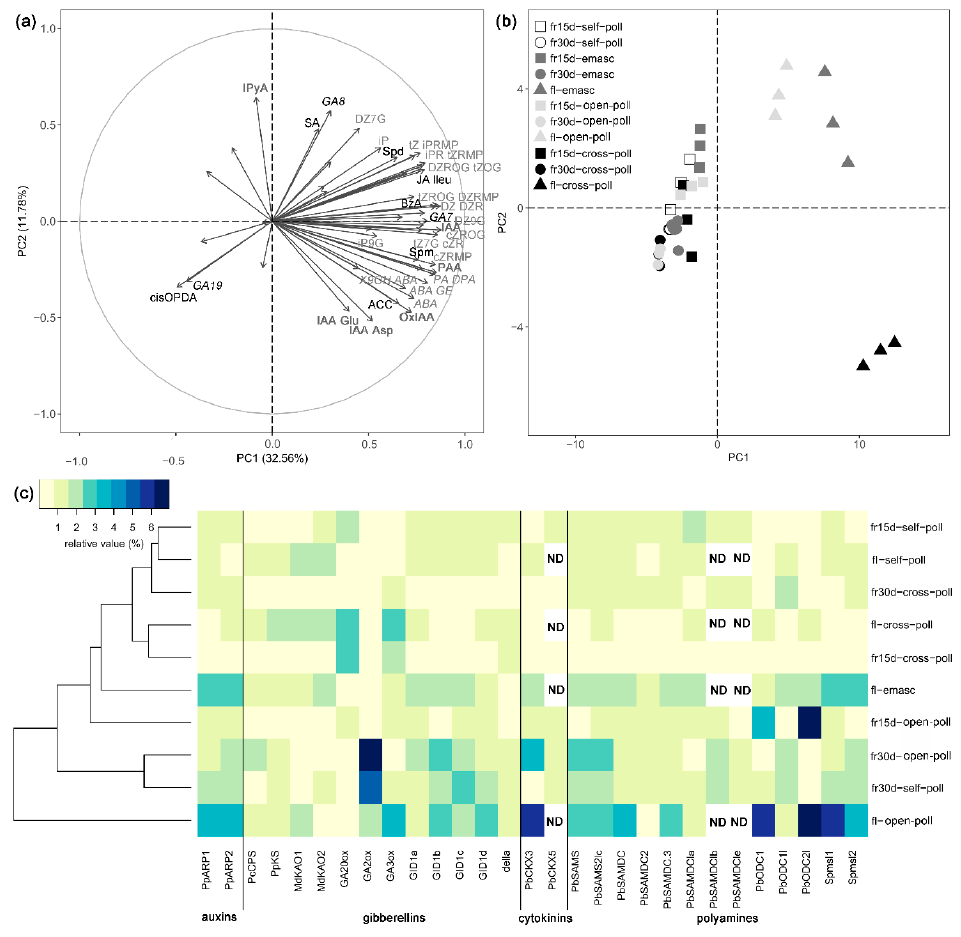
Figure 3. Effects of fertilization and intrinsic parthenocarpy on hormonal regulation during early fruit development of ‘Conference’ pear fruits. ( a - b ) Principal Component Analysis (PCA) of phytohormone and polyamine profiles in flowers and young ‘Conference’ fruits after different pollination and emasculation treatments; (a) variable graph and (b) individual graph; only significant parameters were shown (P< 0.05) in (a). ( c ) Heatmap of relative transcript levels of genes involved in phytohormone and polyamine metabolism and signaling in ‘Conference’ flowers and young fruits after different pollination and emasculation treatments. Abbreviations: Flowers (fl), 15-day-old fruits (fr15d) and 30-day-old fruits (fr30d) after emasculation (emasc), self-pollination (self-poll), cross-pollination (cross-poll) and open-pollination (open-poll). Auxins metabolites (IAA-Asp, indole-3-acetic acid aspartate; IAA-Glu, indole-3-acetic acid glutamate; OxIAA, oxo-indole-3-acetic acid; PAA, phenylacetic acid; IPyA, indole-3-pyruvic acid (IAA precursor), bold dark grey). Abscisic acid metabolites (ABA, abscisic acid; ABA-GE, ABA-glucose ester; PA, phaseic acid; DPA, dihydrophaseic acid; 9OH-ABA, 9-hydroxy-ABA; italic grey). Gibberellins (GA8, gibberellic acid 8; GA19, gibberellic acid 19; black italic). Jasmonates (JA-Ileu, JA-isoleucine; cis OPDA (JA precursor); black). Cytokinin metabolites (tZ, trans-zeatin; tZ7G, trans-zeatin 7-glucoside; tZOG, trans-zeatin O-glucoside; tZROG, trans-zeatin 9-riboside -O-glucoside; tZRMP, trans-zeatin 9-riboside-5 (cid:48) -monophosphate; cZR, cis-zeatin 9-riboside; cZOG, cis-zeatin O-glucoside; cZROG, cis-zeatin 9-riboside-O-glucoside; cZRMP, cis-zeatin 9-riboside-5 (cid:48) -monophosphate; DZ, dihydrozeatin; DZR, dihydrozeatin 9-riboside; DZ9G, dihydrozeatin 9-glucoside; DZROG, dihydrozeatin 9-riboside-O-glucoside; iP, N 6 -( ∆ 2 -isopentenyl)adenine, iPR, N 6 -( ∆ 2 -isopentenyl)adenosine; iP9G, N 6 -( ∆ 2 -isopentenyl)adenine 9-glucoside; iPRMP, N 6 -( ∆ 2 -isopentenyl)adenosine-5 (cid:48) -monophosphate; grey). SA, salicylic acid; BzA, Benzoic acid; PAA, Phenylacetic acid; ACC, 1-aminocyclopropane-1-carboxylic acid (ethylene precursor). Genes are annotated as described in Table